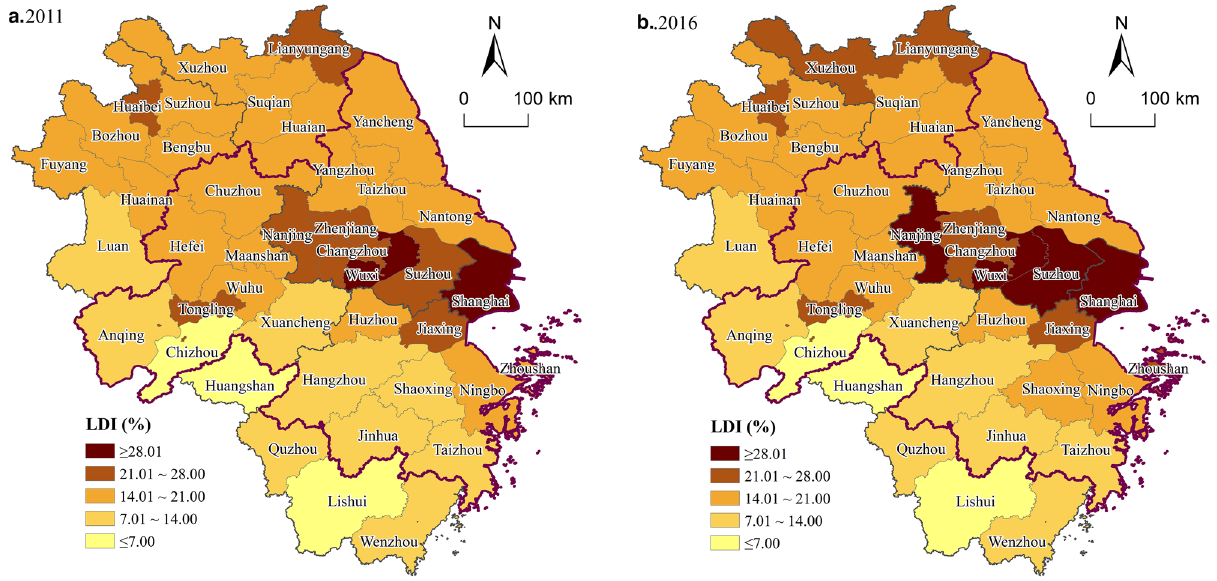
Figure 3. The spatial distribution of the LDI at the municipal level in YRD. ( a ) 2011; ( b ) 2016. Software: Arcgis 10.7. URL: https:// www. esri. com/ zh- cn/